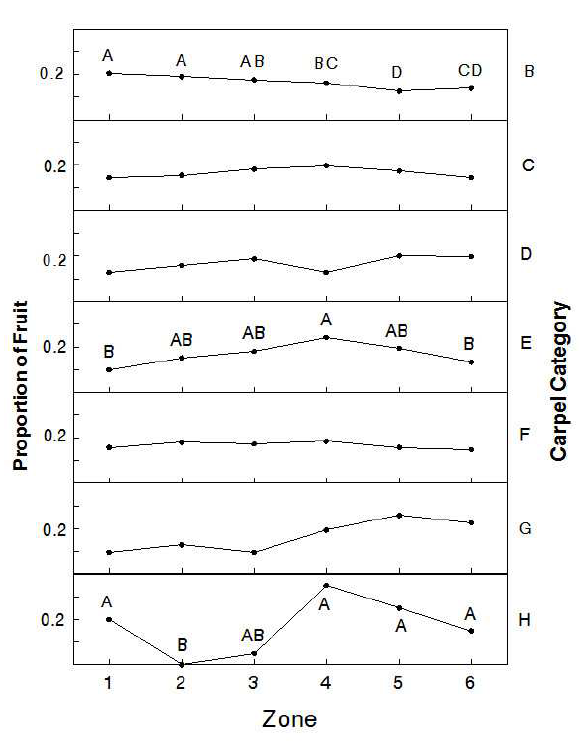
F IGURE 10. The proportions of fruits in each zone representing each carpel category (right Y-axis; see Fig. 2). Zone 1 is closest to Osmia nests, Zone 6 most distant. Points within a single graph sharing letters are not significantly different (multiple comparisons for proportions, q 0.05,6 =4.033); points in graphs without letters are not significantly